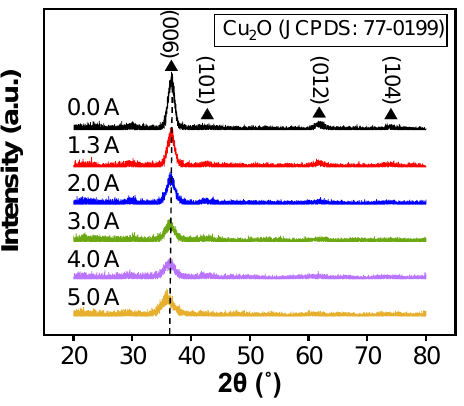
Figure 2. The X-ray diffractometer (XRD) patterns of Cu 2 O films deposited with various oxygen ion beam current.